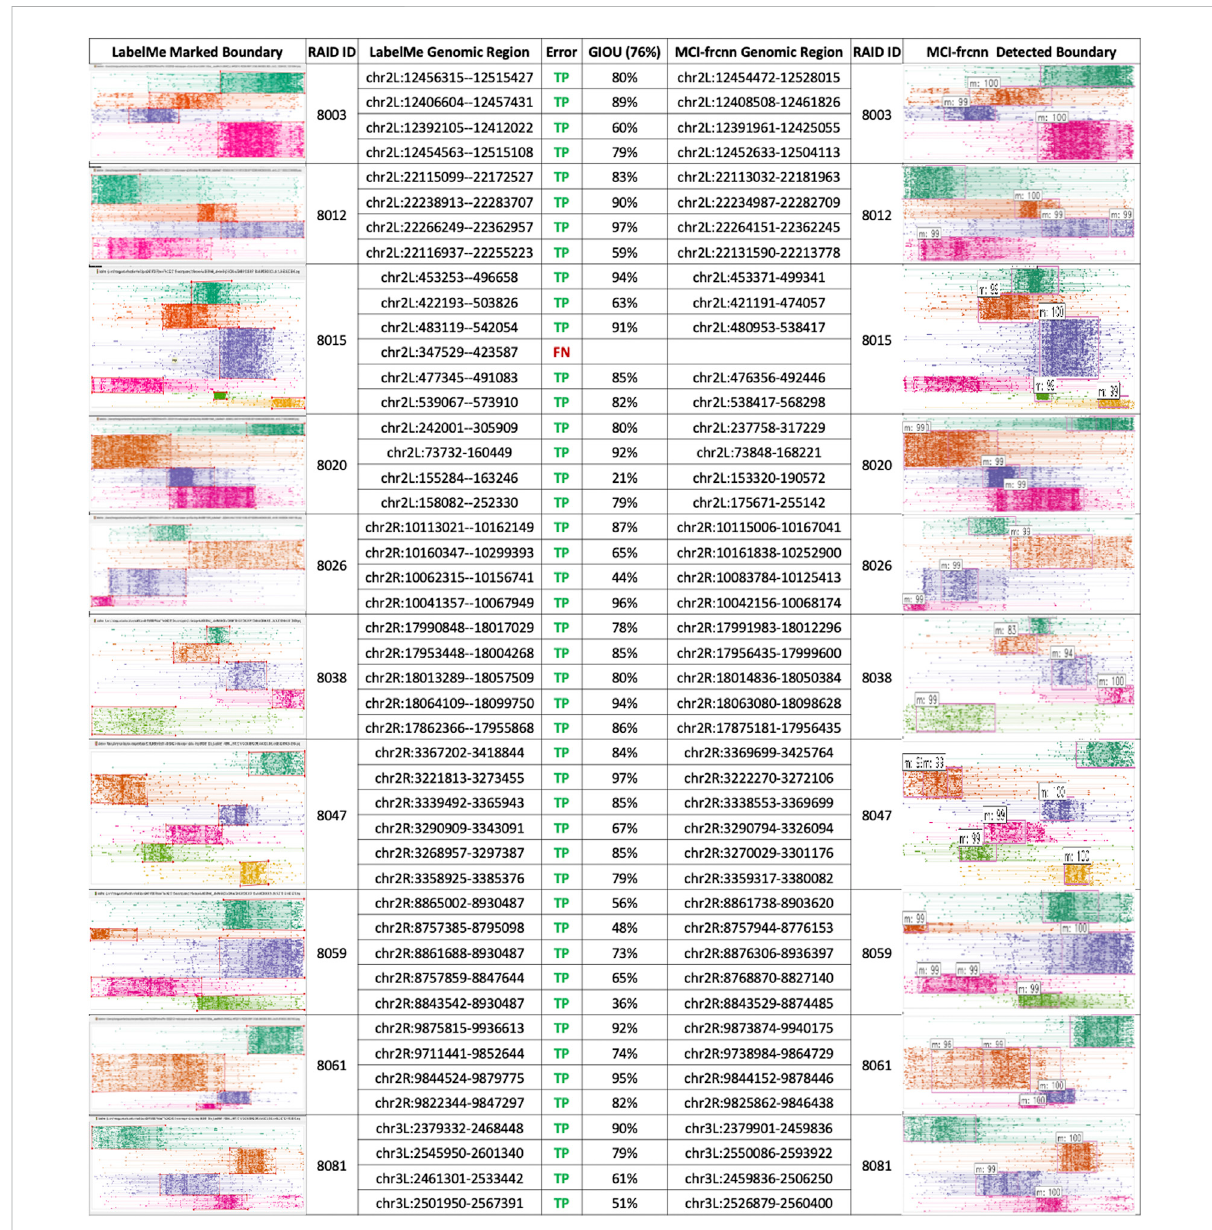
FIGURE 4 MCI-frcnn detection results. Table of the results of micro-domain boundaries detected from the 10 new RAID clustering images using MCI- frcnn (right side), and their corresponding ground truth boundaries on the left-side. gIoU and error type of each micro-domains are listed in the middle